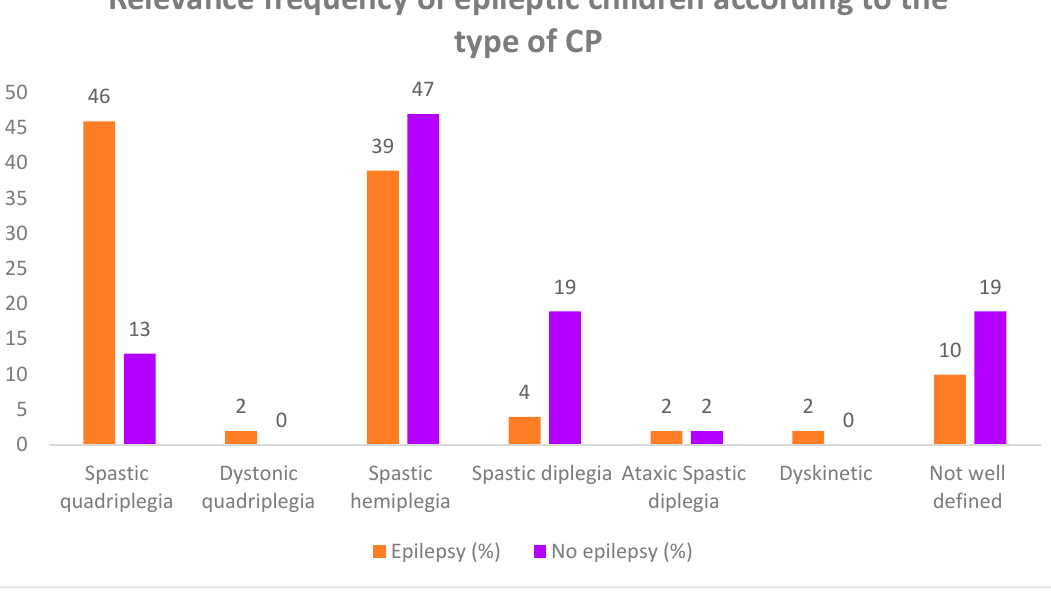
Legend: % = relevance frequency. Figure 4. Relevance frequency of epileptic children according to the type of CP. Figure 4 . Relevance frequency of epileptic children according to the type of CP. 3.1.4. The GMFCS levels were performed in 28 CP children and, among these, in 12 CP higher in the former (46% vs. 39%; p = 0.02). As in the comparison with the chil- Table 3. GMFCS Levels and frequency of epilepsy carried out in 28 affected plegic children (46% vs. 4%; p = 0.002). Instead, no statistically significant differ- ence was found in the comparison between hemiplegic and diplegic children.